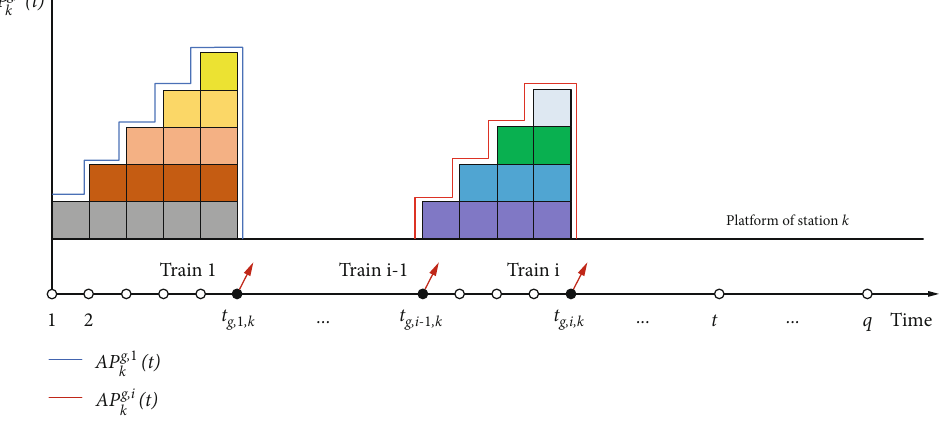
Figure 3: Illustration of passenger accumulating process on the platform for the approaching train.